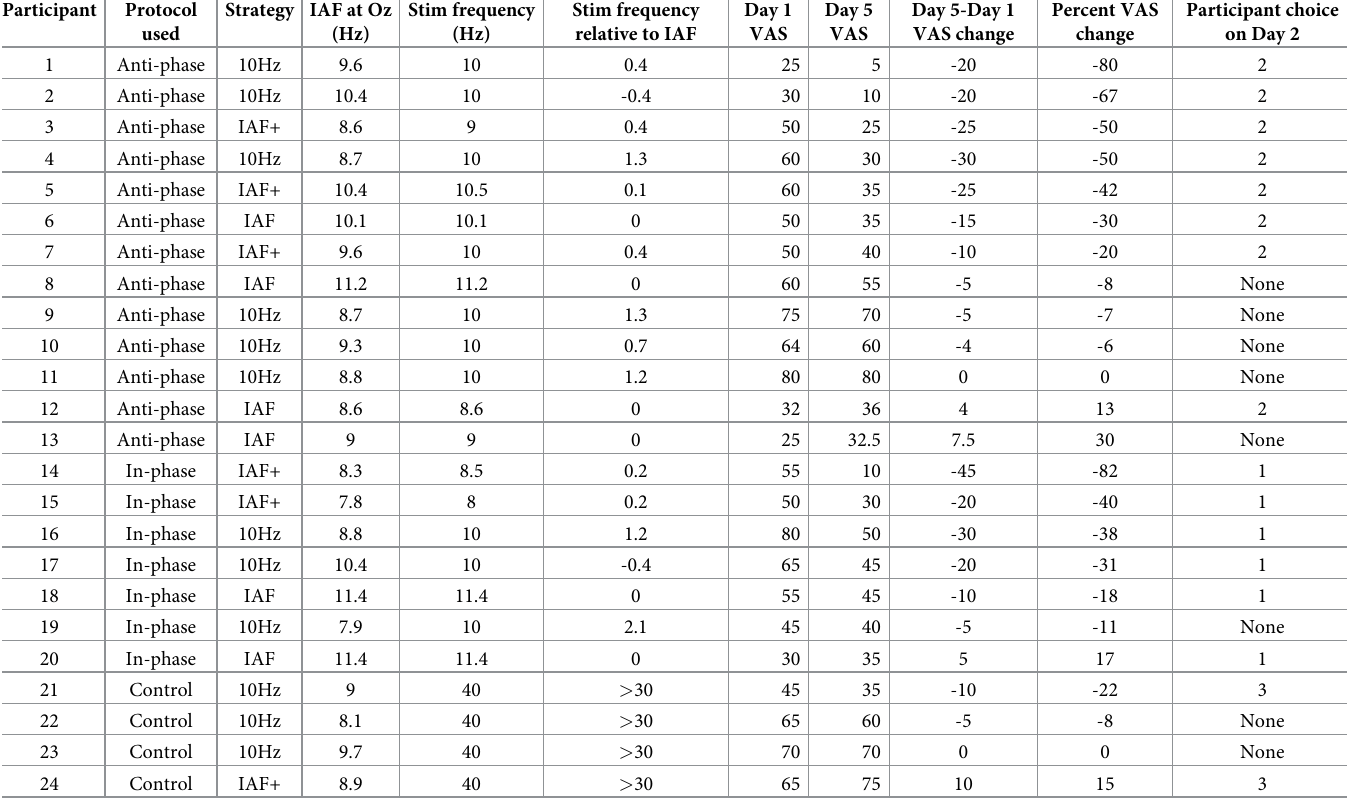
Table 2. Individual treatment response by protocol, frequency relative to IAF, and initial participant choice.